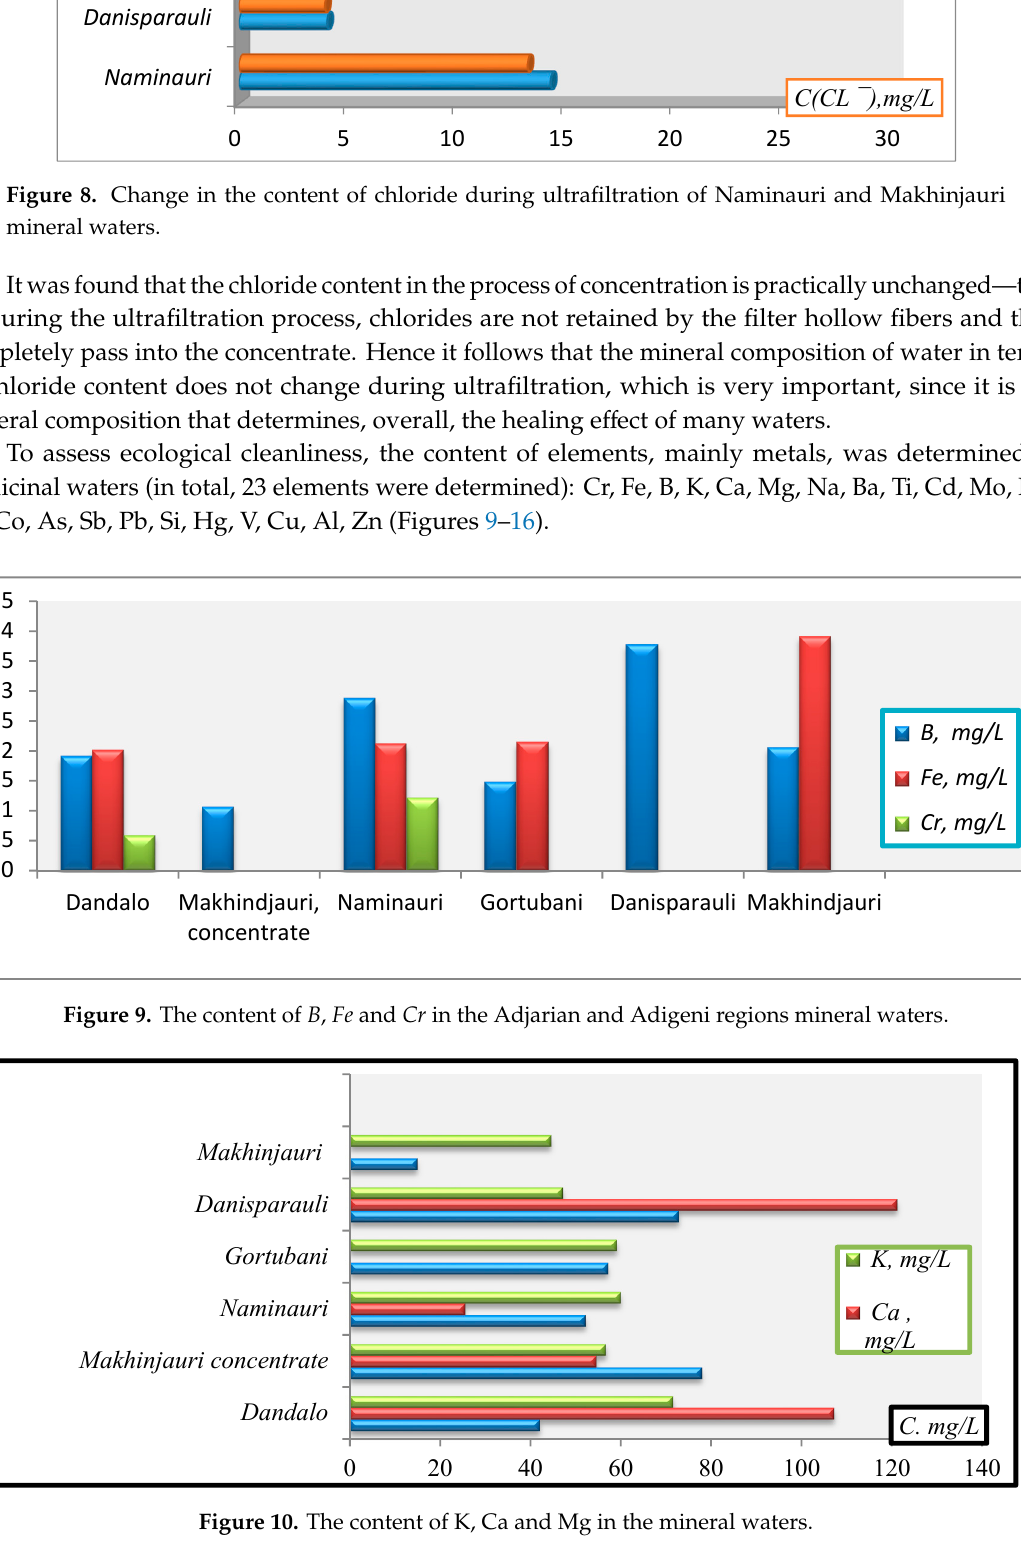
Figure 8. Change in the content of chloride during ultrafiltration of Naminauri and Makhinjauri mineral waters.